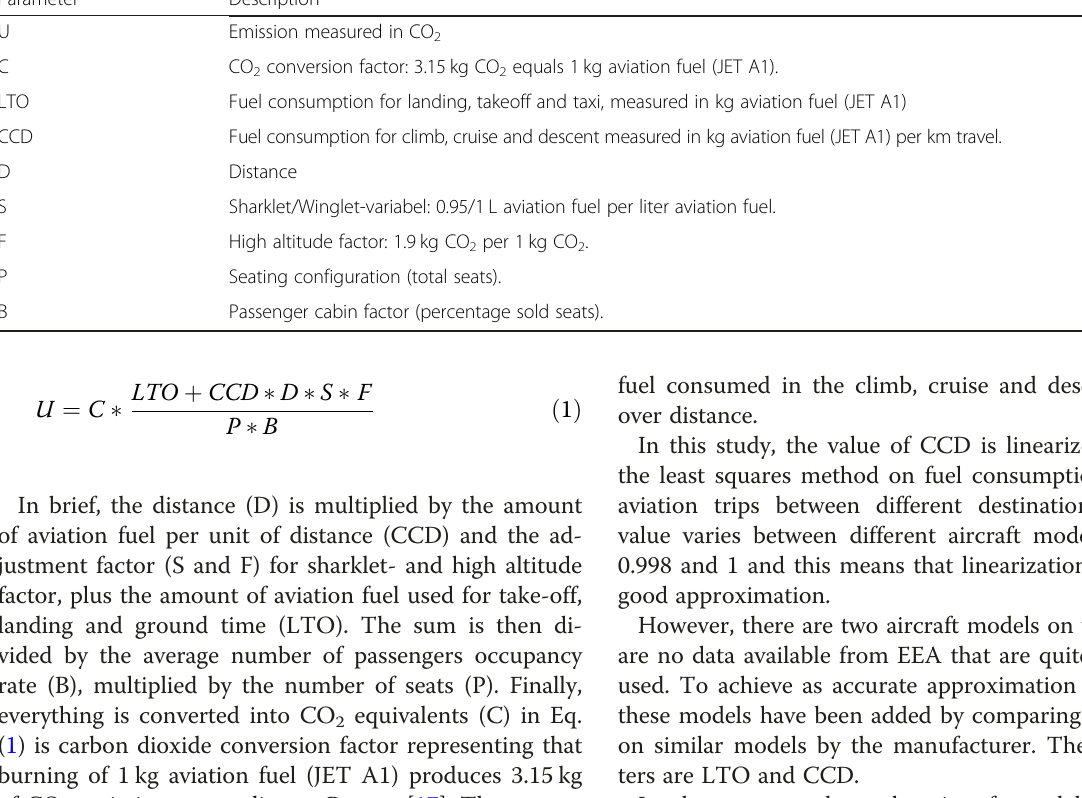
Table 1 Parameters used for calculating emissions from flight bookings Parameter